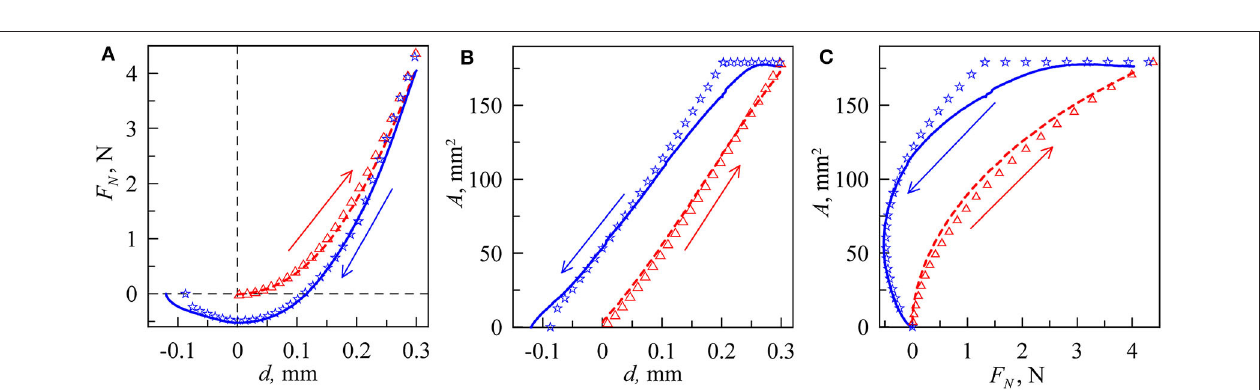
FIGURE 4 | General behavior of main macroscopic parameters during indentation (dashed red lines) and pull-off (solid blue lines): (A) dependence of normal force F N vs. indentation depth d , (B) dependence of contact area A vs. indentation depth d , (C) dependence of contact area A vs. normal force F N . These dependencies were obtained in real experiment in the case of P2000 for the indenter of the radius R = 100mm. With symbols, the results of the computer simulation are shown: triangles for absence of adhesive interaction γ 12 = 0 J/m 2 and stars for the value γ 12 = 0.9 J/m 2 .